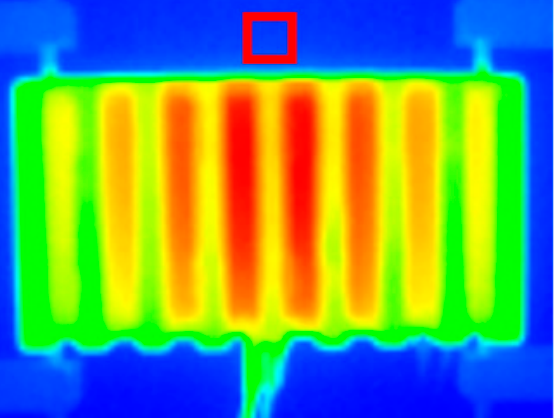
Figure 7. Thermal picture with an indicated area where the thermocouple for the verification of the correct measured temperature via thermal imagery was put.